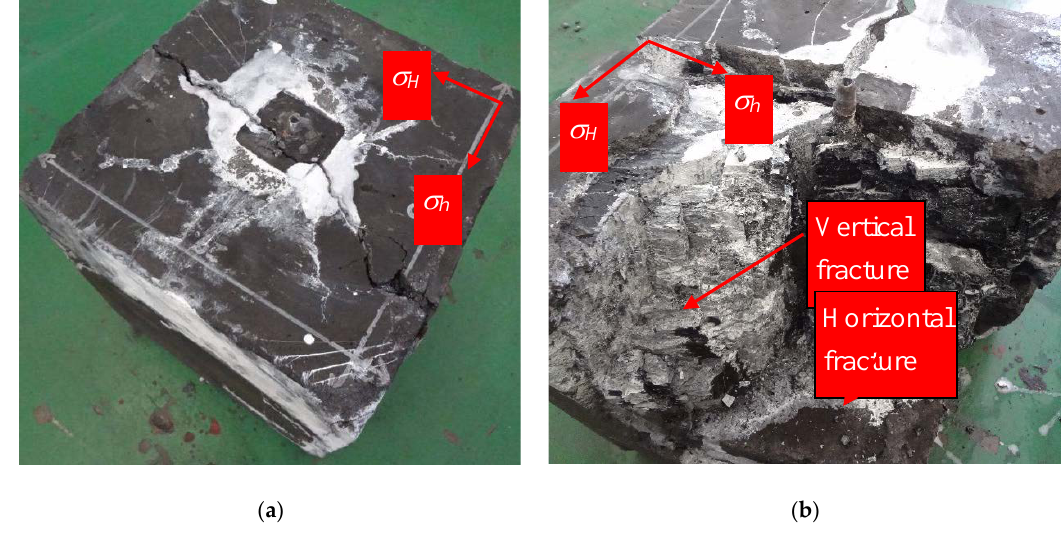
Figure 4. Morphology of hydraulic fracturing fractures in large-size coal sample. ( a ) A schematic diagram of loading direction and coal sample; ( b ) A schematic of vertical fracture and horizontal fracture after hydraulic fracturing. Table 1. Coal fracturing test parameters and statistics of fracture